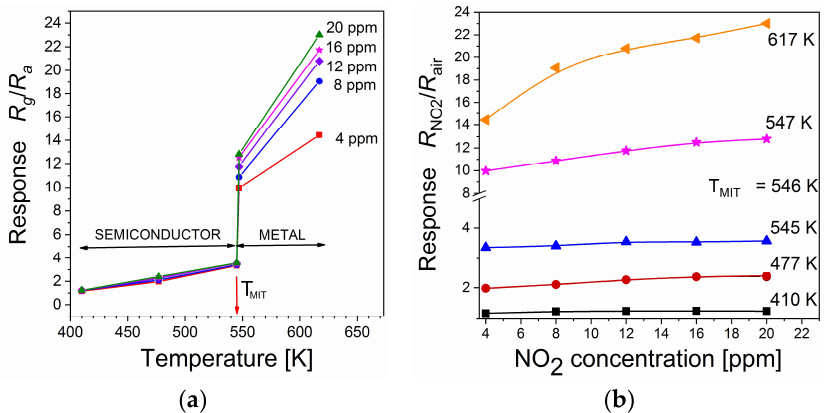
Figure 5. The sensor response S : ( a ) vs. temperature for various NO 2 concentrations and ( b ) vs. NO 2 concentration for different temperatures.